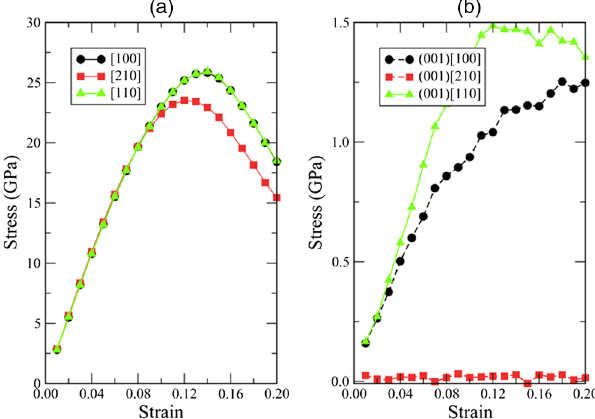
FIG. 6 (color online). Computed stress-strain relations under (a) the tensile load along different directions and (b) the shear load in the (001) plane and along different directions.